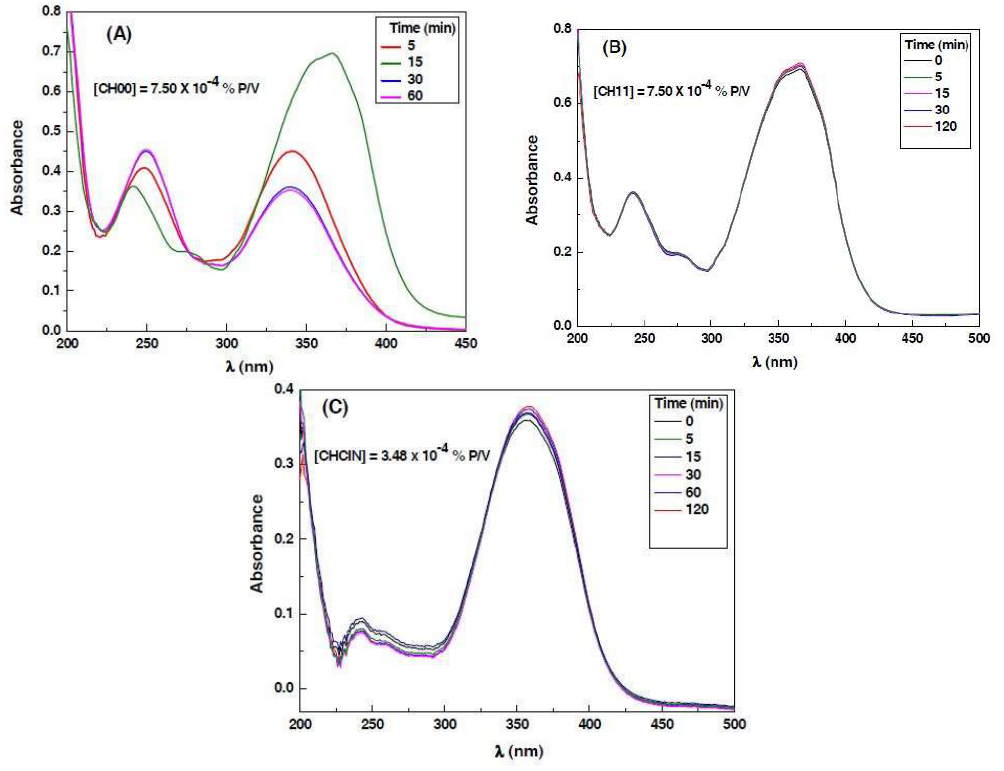
Figure 8. Photodecomposition of chalcones: ( A ) CH00; ( B ) CH11; ( C ) CHCIN.